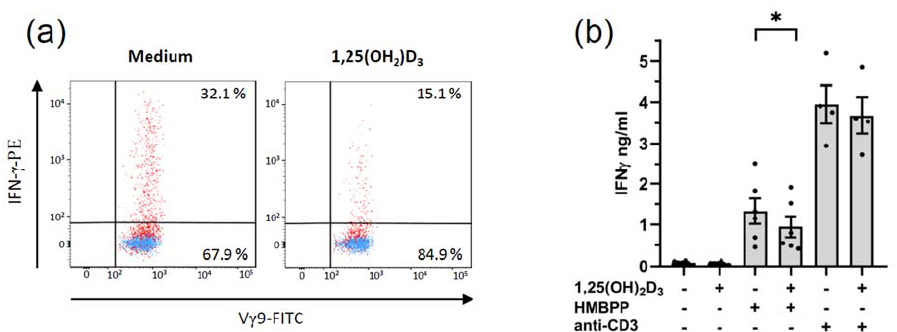
Figure 7. 1,25(OH) 2 D 3 inhibits IFN- γ induction in γδ T cells. ( a ) PBMC were activated with 2.5 µ M ZOL in the absence (left dot plot) or presence (right dot plot) of 50 nM 1,25(OH) 2 D 3 . After 48 h, cells were stained for intracellular detection of IFN- γ in CD3 + V γ 9 + T cells. One of two experiments is shown. ( b ) γδ T cell lines generated from ZOL-activated PBMC and expanded for 14 d were cultured overnight in a medium ( n = 6), with HMBPP ( n = 6) or immobilized anti-CD3 antibody ( n = 4) in the absence or presence of 50 nM 1,25(OH) 2 D 3 , as indicated. IFN- γ in culture supernatants was measured by ELISA. Statistical analysis was performed with Wilcoxon matched pairs signed-rank test. * p =